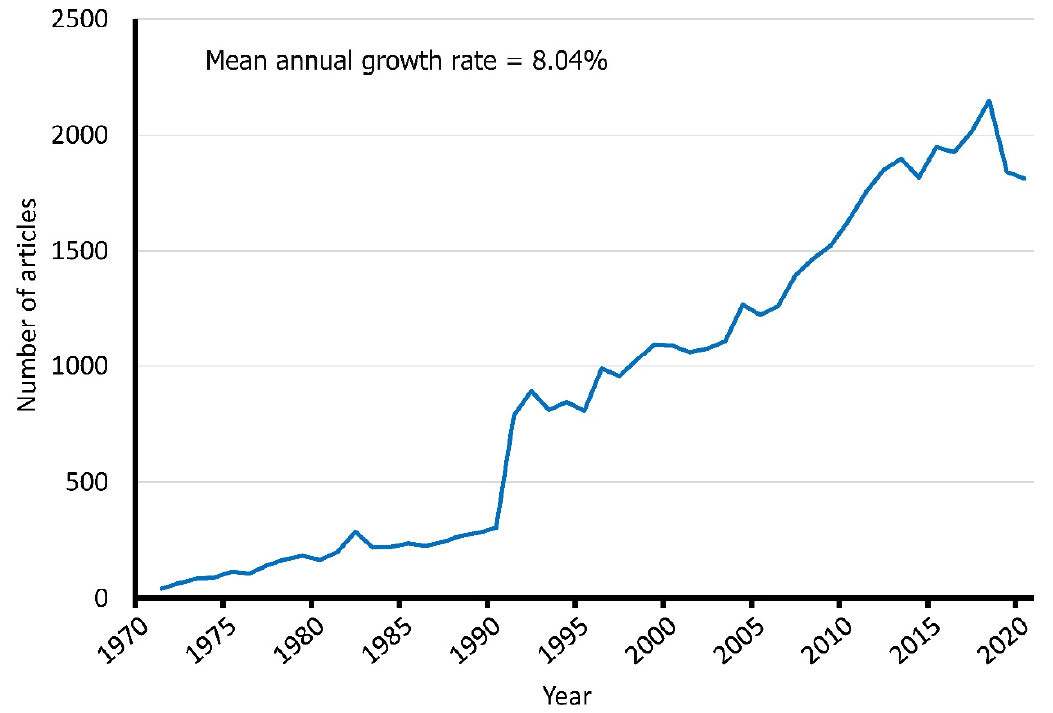
Figure 1. Annual number of original articles on systemic lupus erythematosus from 1971 to 2020. Table 2. The top 10 most productive countries, based on the affiliation of the corresponding author of original articles on systemic lupus erythematosus from 1971 to 2020.